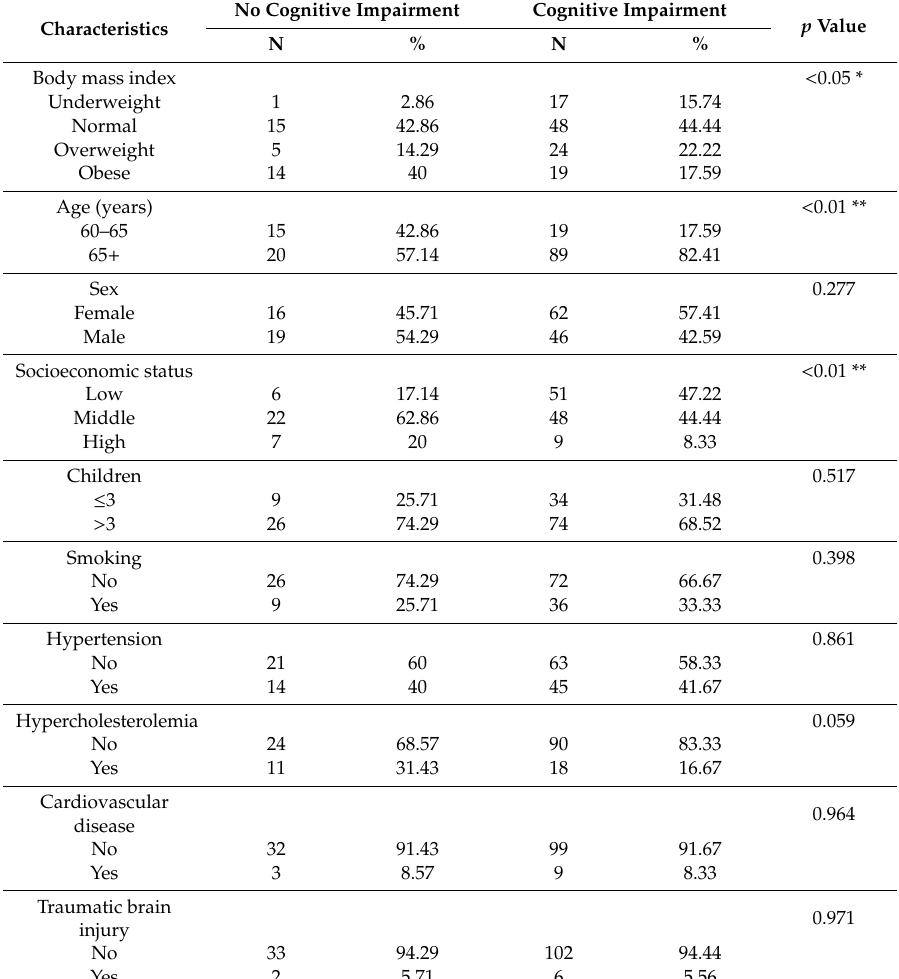
Table1. Bodymassindex(BMI),sociodemographiccharacteristics,